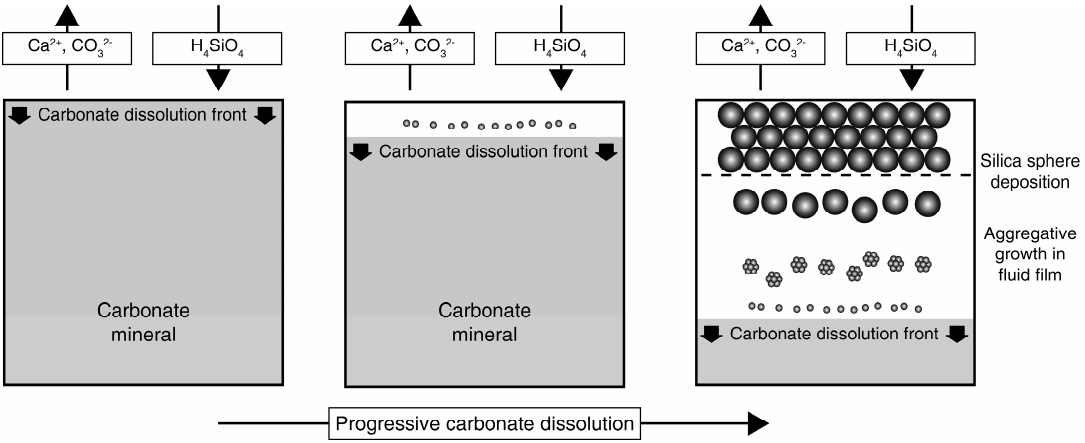
Figure 8. Schematic representation of the volume- and texture-preserving replacement process of a carbonate mineral by amorphous silica nanospheres. Carbonate chemical components are constantly removed into the bulk solution, while dissolved silica (H 4 SiO 4 ) reaches the carbonate surface. Amorphous silica nanoparticles continuously nucleate close to the carbonate surface, aggregate into larger particles in the interfacial fluid film, and self-assemble into close-packed, hexagonal planes. The particle diameter increases at increasing distance from the dissolution front until they reach their final size. The carbonate dissolution and silica deposition fronts advance synchronously during the interface-coupled dissolution-precipitation process. The final spheres form a long-range ordered photonic